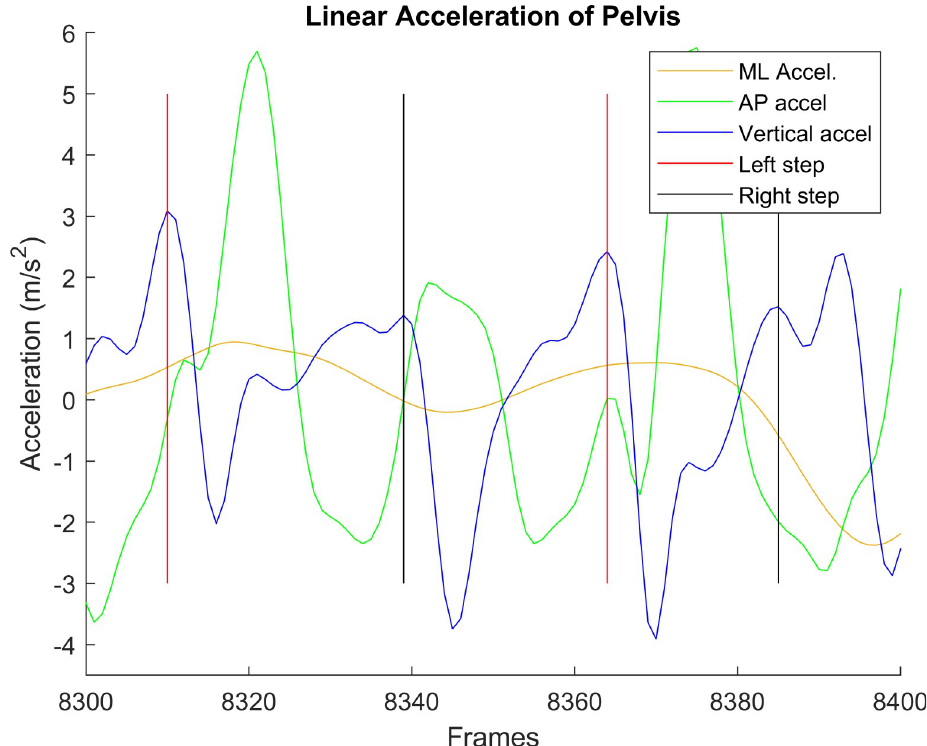
Fig 3. Anterior-posterior (blue), vertical (green), and medial-lateral (yellow) accelerations before manual step identification. Black lines indicate right steps, red lines indicate left steps. Manual step identification was required around frame